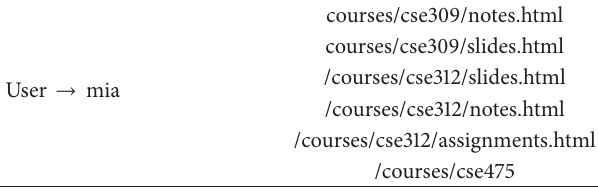
Table 3: Sample recommendations given to a user by the WebBluegillRecom-annealing dynamic recommender system with 𝐼 = 6 . courses/cse309/notes.html User → mia